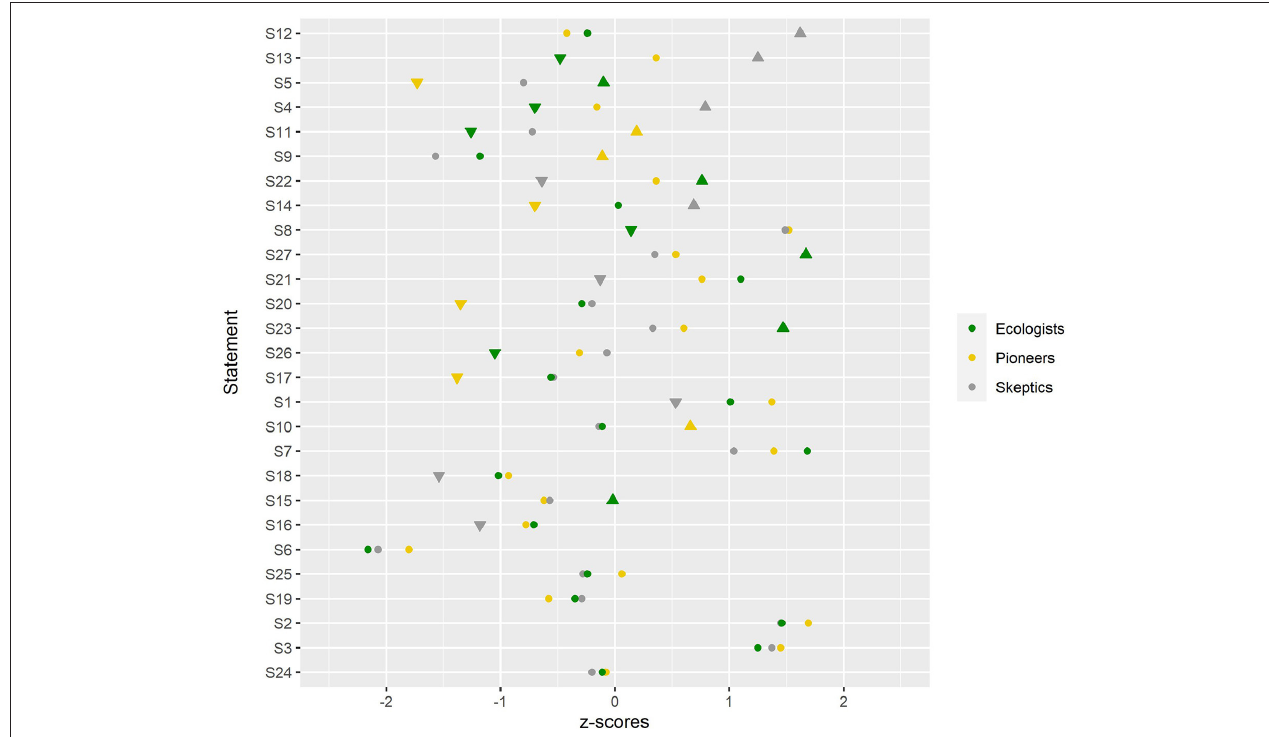
FIGURE 3 | Ranking of statements from most controversial (Top) to least controversial (Bottom) . Triangle symbols highlight distinguishing statements with a significance at P < 0.01 and where the Z-scores for the statement is higher ( N ) or lower ( H ) than for all other factors.